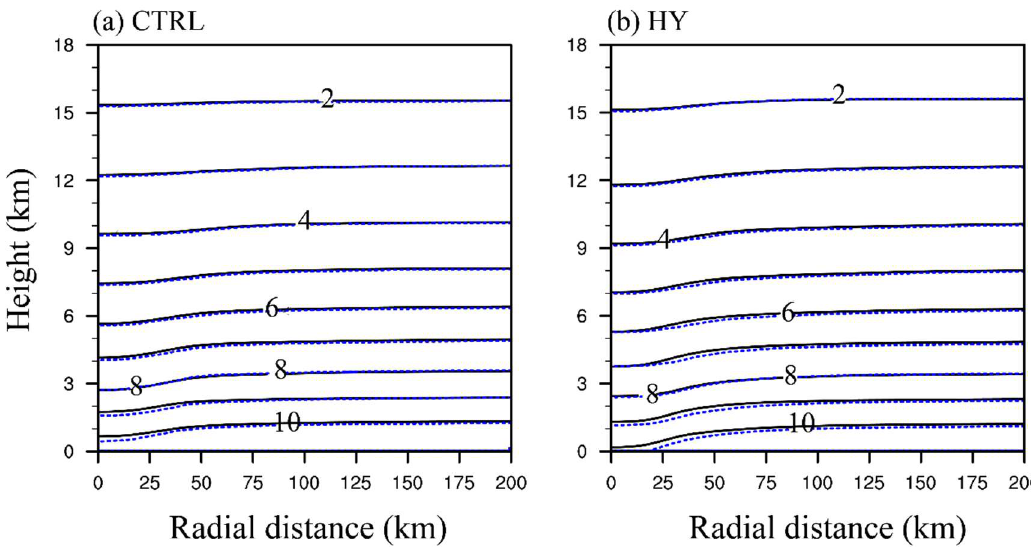
Atmosphere 2019 , 10 FOR PEER REVIEW 16 Figure 13. Height–radius cross-sections of the azimuthal-mean ∂ p / ∂ z (black line; Pa m − 1 ) and − ρ g Figure 13. Height–radius cross-sections of the azimuthal-mean 𝜕𝑝/𝜕𝑧 (black line; Pa m (cid:2879)(cid:2869) ) and −ρg region is stronger in HY than in CTRL and that the vertical winds in HY can reach a greater height, (gray line; Pa m − 1 ) for ( a ) CTRL and ( b ) HY averaged between 84 and 96 h. (gray line; Pa m (cid:2879)(cid:2869) ) for ( a ) CTRL and ( b ) HY averaged between 84 and 96 h. which is consistent with the larger vertical acceleration (Figure 6b).